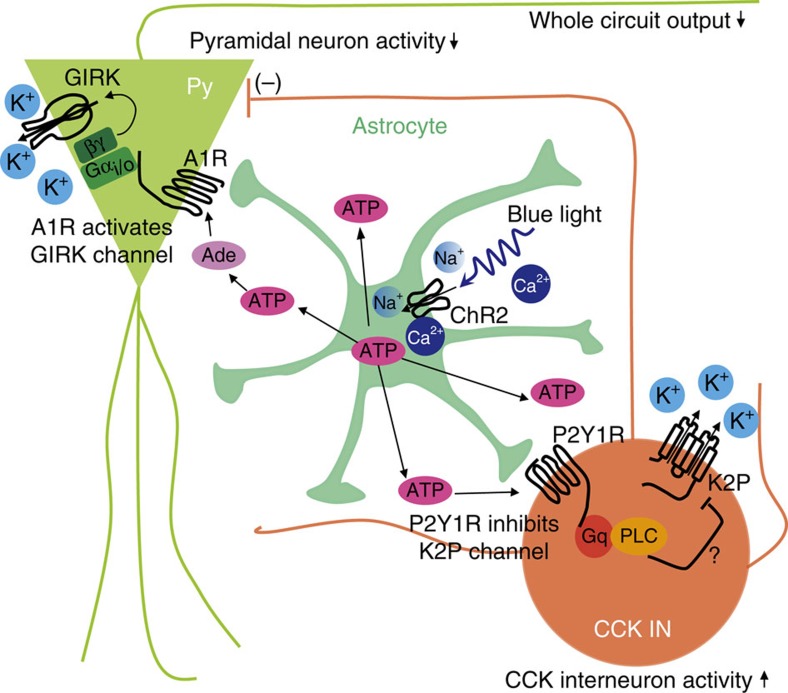
Working model of astrocytes inversely modulates the excitability of pyramidal (Py) neurons and interneurons.Light activation of ChR2-expressing astrocyte (centre) induces ATP release, which directly increases the excitability of CCK+ interneurons (right) through P2Y1 receptor-mediated inhibition of K2P potassium channels. The astrocyte-released ATP can be degraded into adenosine (Ade), which in turn decreases the excitability of pyramidal neurons (right) through A1 receptor-mediated activation of GIRK channels. The ATP-induced excitation of CCK+ interneurons will further inhibits pyramidal neuron activity through GABAergic synapses. In this way, the astrocyte-derived ATP efficiently regulates the output of whole neuronal circuit.